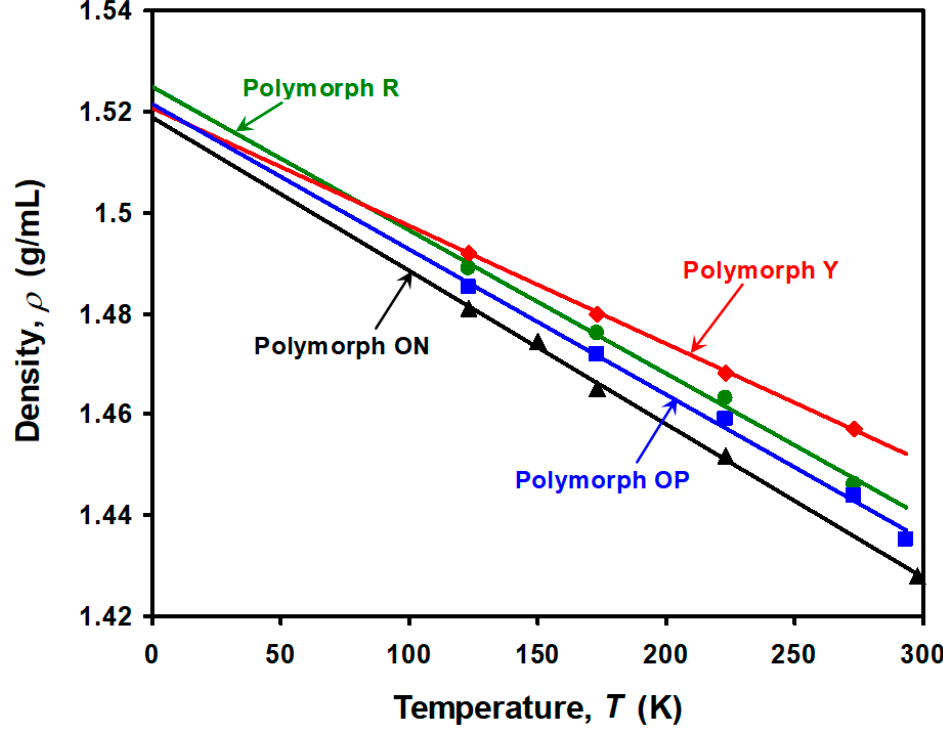
Figure 8. Thermal density profiles ( ρ –T ) of polymorphs Y, R, OP, and ON.